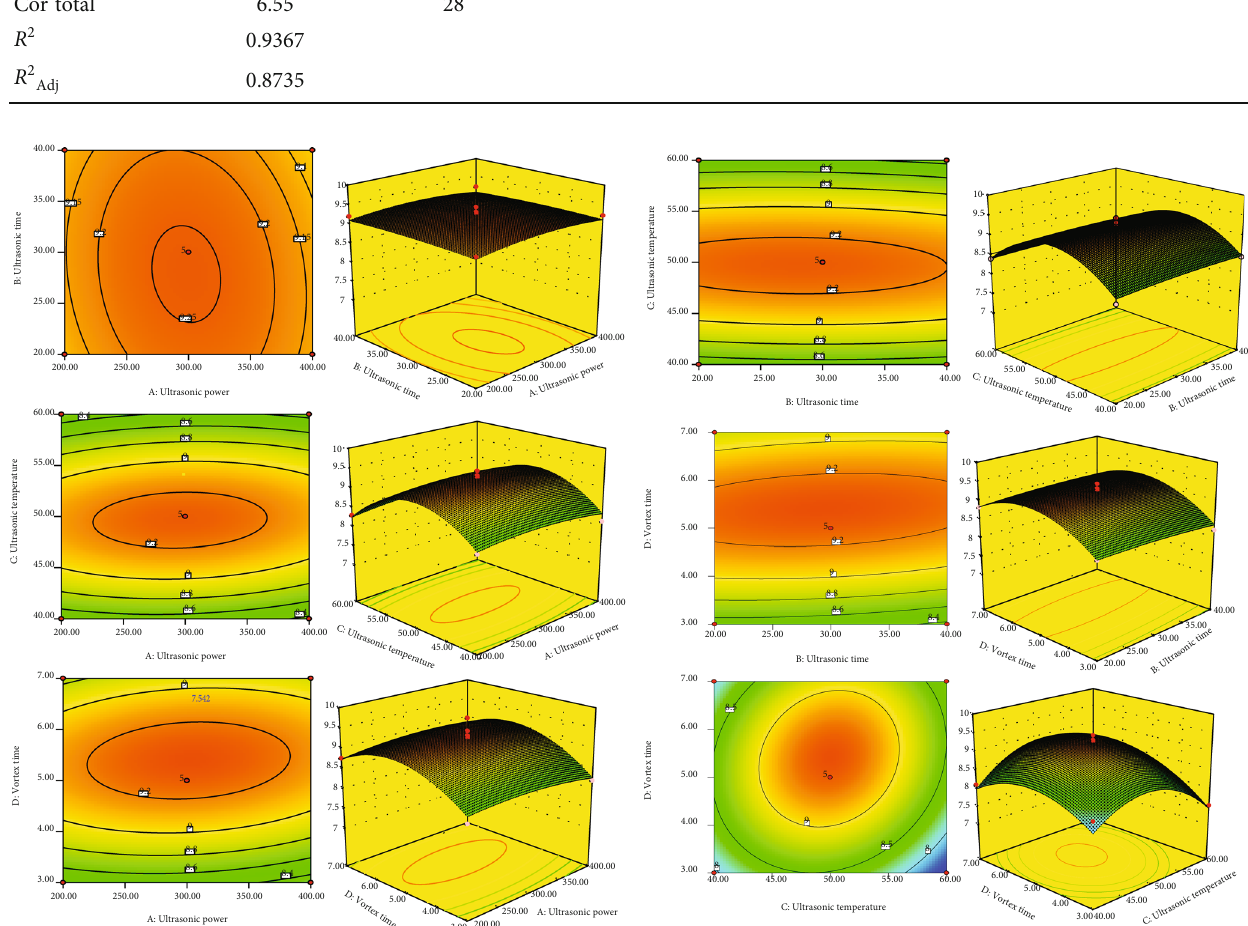
Figure 9: Response surface drawings of Moutan Cortex analyzed by the interaction of two